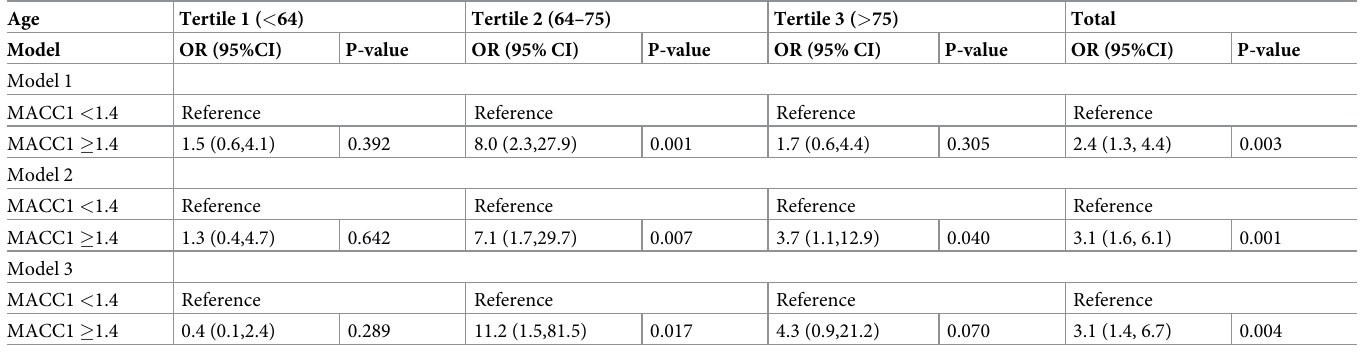
online databases in May 2021 to analyze the expression of MACC1 mRNA in Colon adeno- carcinoma (COAD) and Rectum adenocarcinoma (READ) [20]. The results showed that MACC1 upregulated in CRC tissues compared with normal tissues (Fig 2B). We used UAL- CAN (http://ualcan.path.uab.edu/analysis.html) online databases in May 2021 to analyze the relationship between MACC1 expression and lymph node metastasis [21]. The results showed that MACC1 upregulated in CRC tissues with lymph node metastasis compared with non-lymph node metastatic (Fig 2C). The results from GEPIA 2 showed that MACC1 had a relatively high correlation with CDH1 and MET, and a weak correlation with MMP9 and SNAI1. MACC1 is also highly correlated with proliferation-related genes MYC and CDK13 (Fig 3).